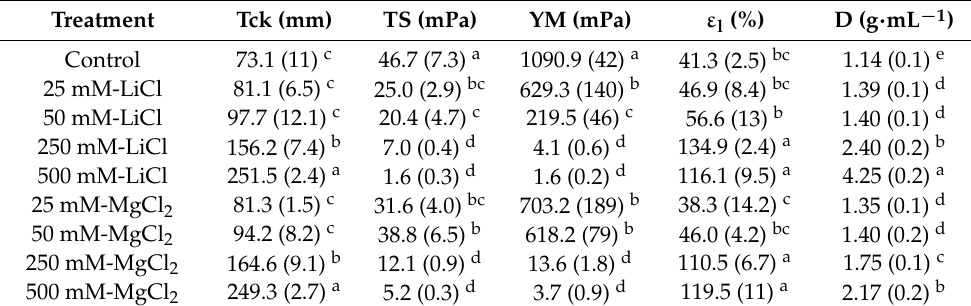
Table 1. Mechanical performance, namely thickness (Tck), tensile strength (TS), Young’s modulus (YM), linear strain ( ε l ) and density (D) of the MC-based films prepared at different IS (0; 25; 50; 250 and 500 mM) due to LiCl or MgCl 2